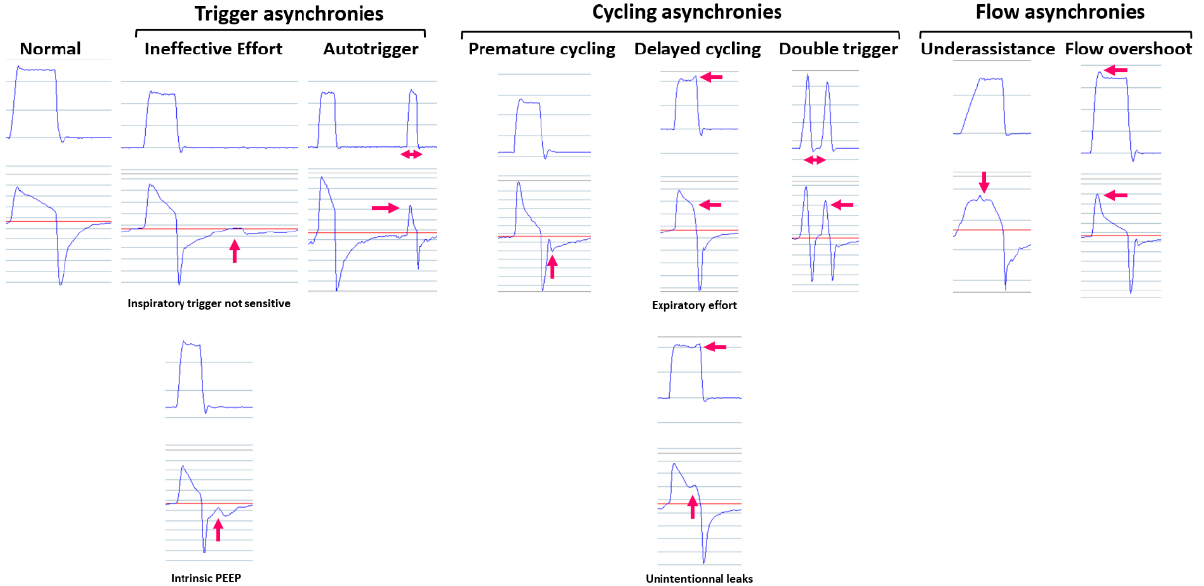
Figure 3. The most common patient–ventilator asynchronies can be detected by monitoring detailed pressure and flow waveforms. Red arrows show where is the asynchrony.